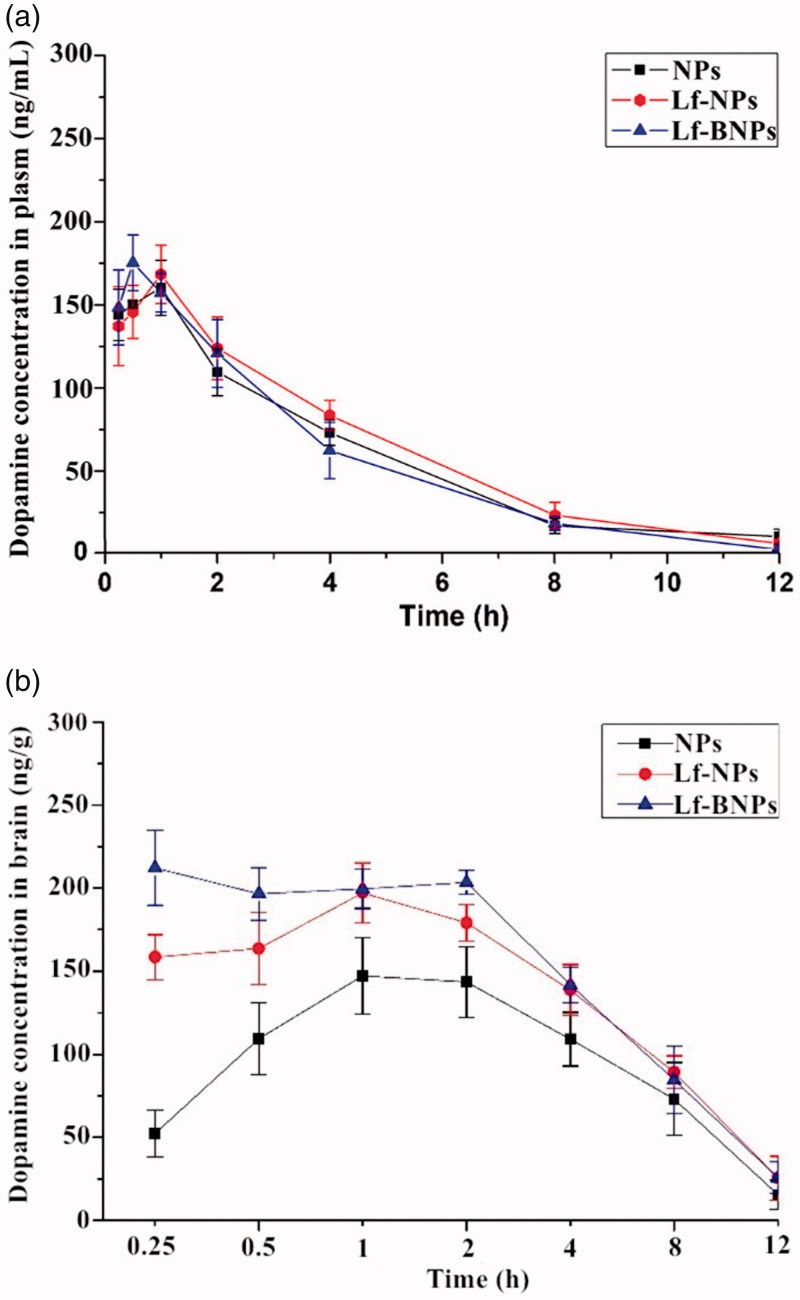
(a) Blood and (b) brain concentration-time profiles of dopamine following intranasal administration of dopamine-loaded NPs, Lf-NPs, and Lf-BNPs. Data represent the mean ± SD.